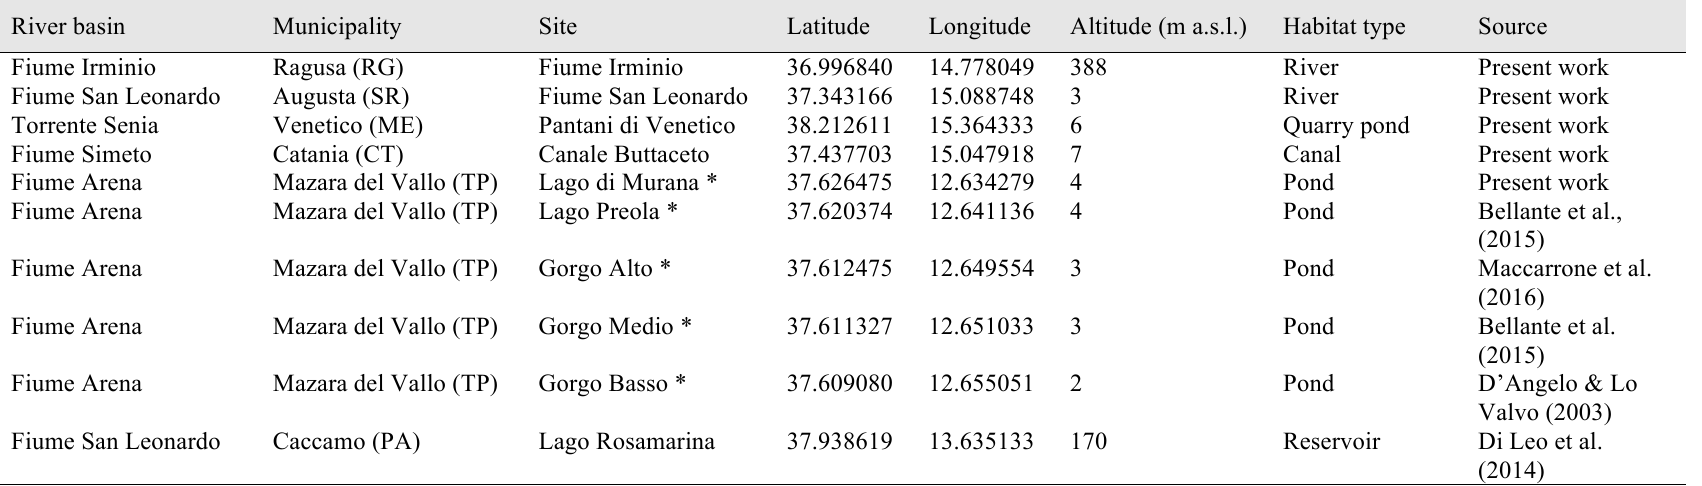
Table 1. Known distribution of Procambarus clarkii in Sicily at May 2017, including both published and novel sites. Latitude and Longitude are expressed as geographical coordinates, decimal degrees (Map datum: WGS84). *: Located within the R.N.I. “Lago Preola e Gorghi Tondi” River basin